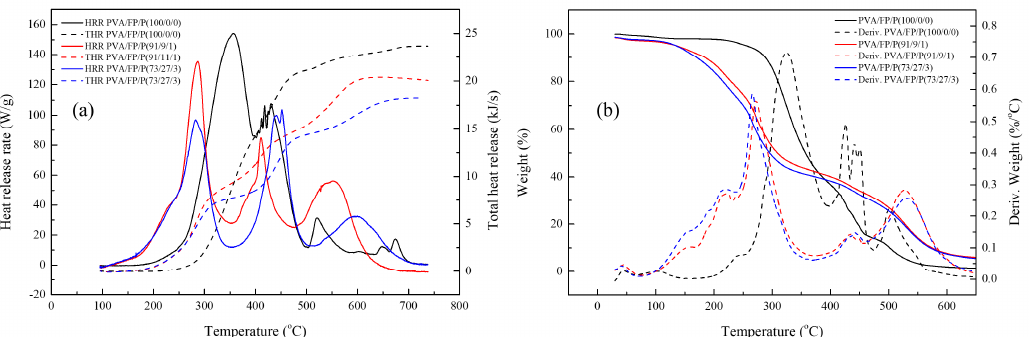
Figure 11. TGA measurements ( a ), Heat release rate (HRR) and total heat release (THR) ( b ) of PVA/PEG-b-PDEVBP; weight ratio of PVA/PEG-b-PDEVBP(FP, B2)/P (phosphorus contents) = PVA/FP/P.